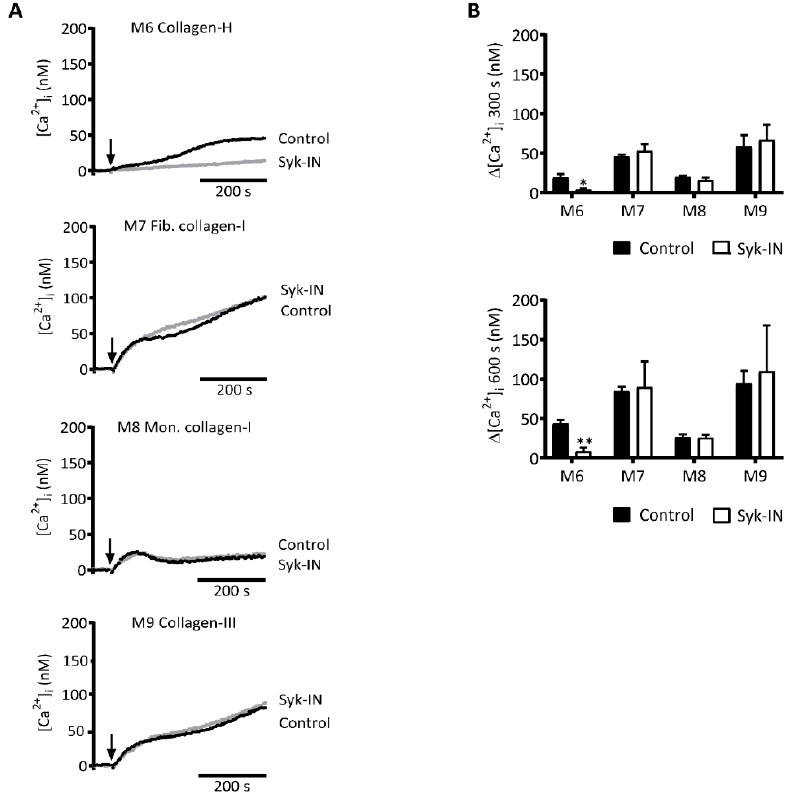
Figure 4. Syk inhibition differently affecting platelet Ca 2+ rises by collagens. Fura-2-loaded platelets in 96-well plates were pre-incubated with Syk-IN (5 µM) or were left untreated before stimulation with different collagens (M6–9, 10 µg/mL). Changes in [Ca 2+ ] i were continuously monitored per well- plate row by ratio fluorometry using a FlexStation 3. Collagens were injected at 60 s (arrow), and they reached platelets in a diffusion-limited way. ( A ) Calibrated [Ca 2+ ] i traces recorded for 600 s in the absence (black, control) or presence (gray) of a Syk inhibitor. Traces are representative of three experiments. ( B ) Quantification of [Ca 2+ ] i rises after 300 s (top graph) and 600 s (bottom graph) for M1–5. Means ± SEM ( n = 3). Paired Student’s t -tests; * p < 0.05, ** p < 0.01.